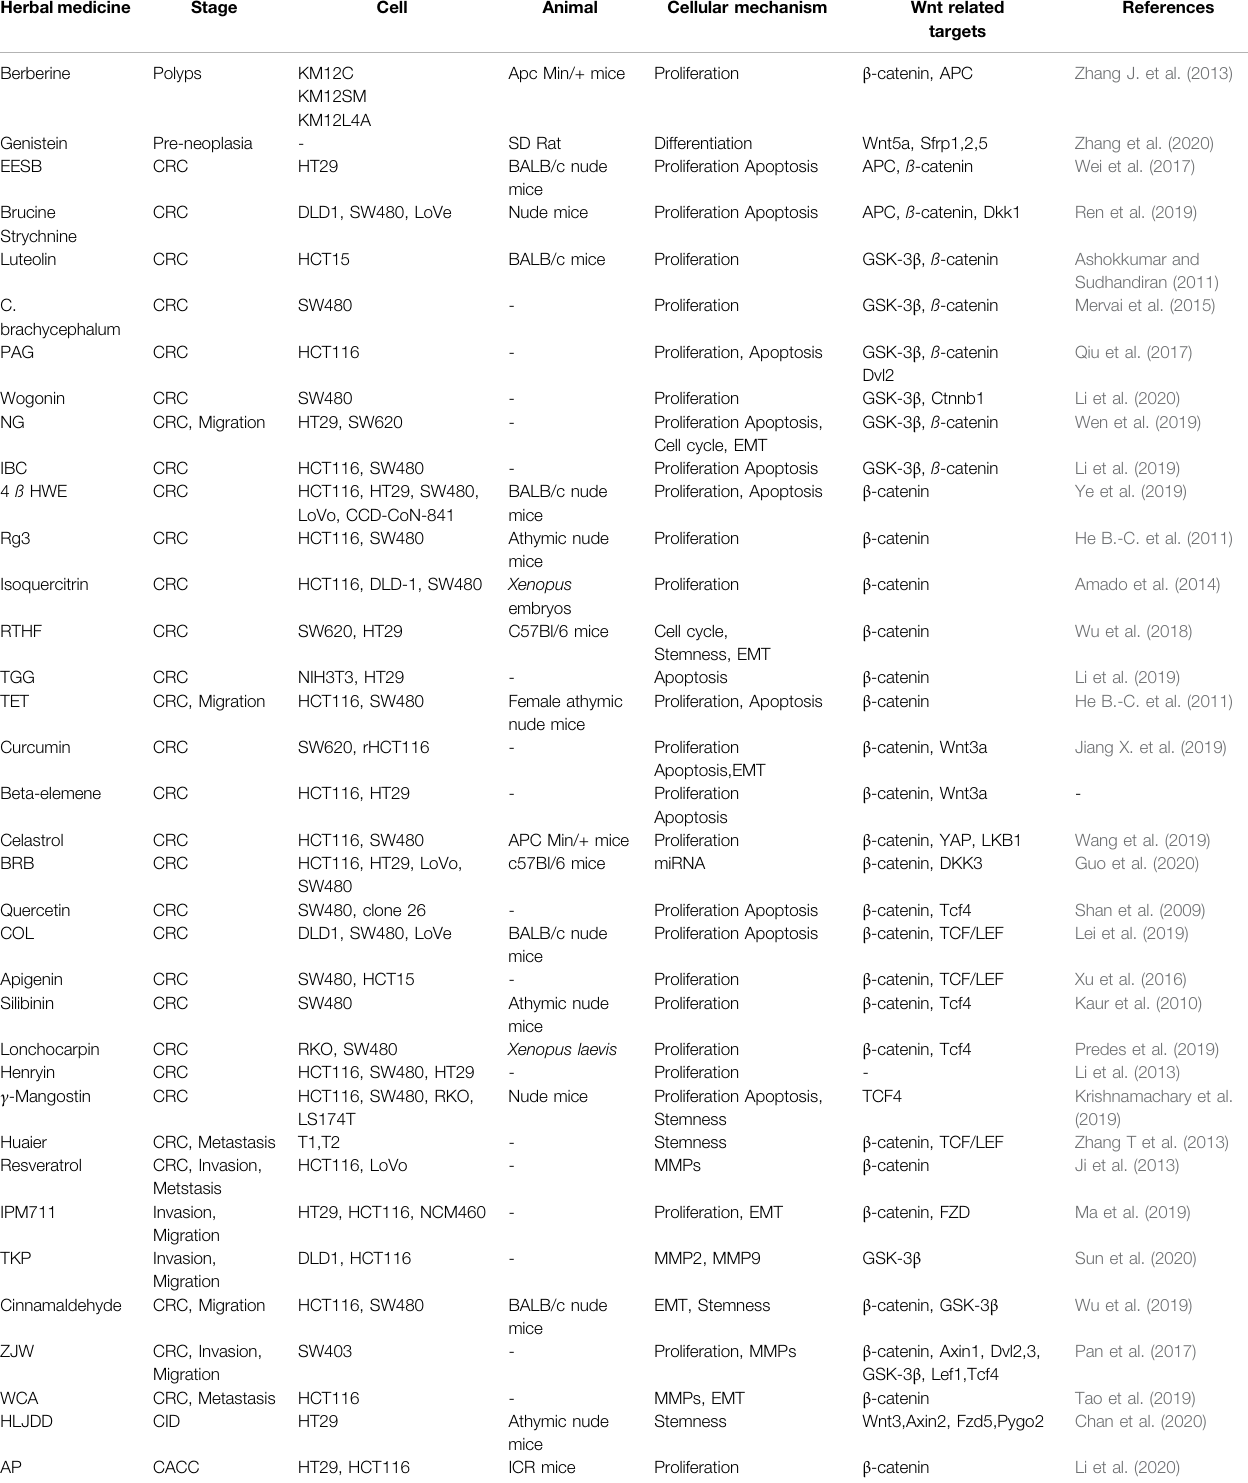
TABLE 2 | Effects of monomers, extracts, formula of TCMs on CRC by Wnt/ β -catenin pathway. Herbal